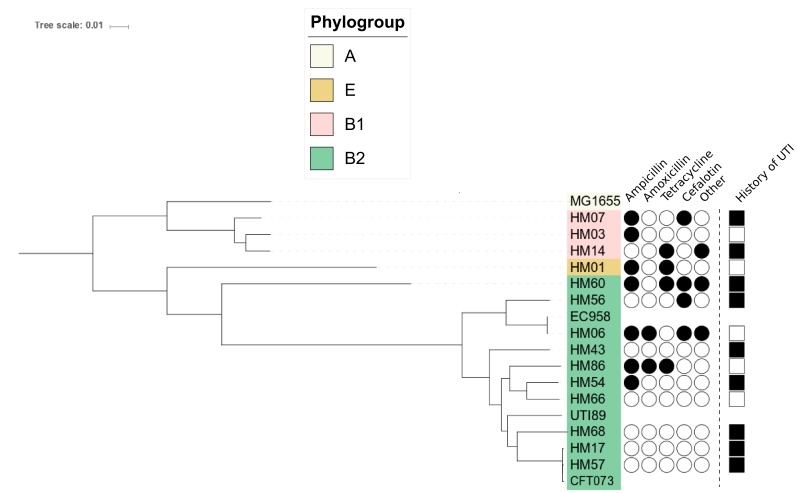
Phylogenetic tree reconstruction of 14 clinical UPEC strains isolated in this study.Antibiotic resistance profiles are indicated by filled in black circles (as determined by VITEK2 system (BioMerieux).) Patients with recurrent UTIs are indicated by filled in black square. MG1655, EC958, UTI89 and CFT073 are included for reference.